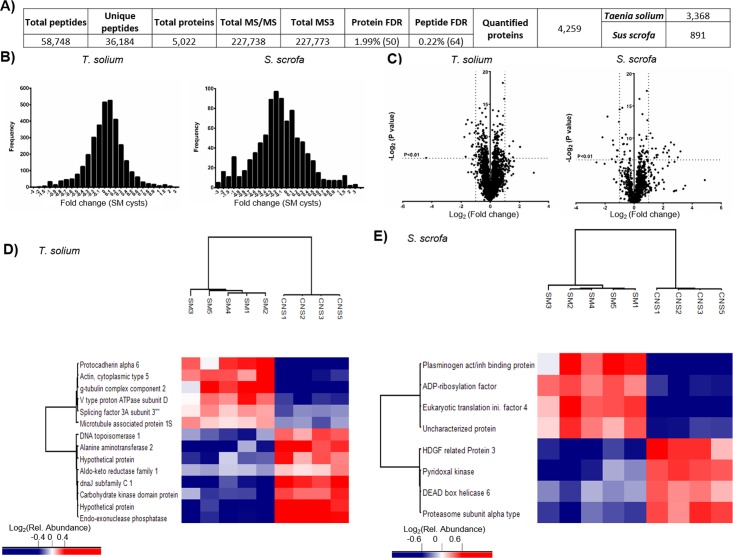
Proteomic analysis of Taenia solium cysts.A) Table summarizing peptide and protein quantification from the nine samples. Proteins were collapsed to a final protein-level FDR < 2%. B) Fold change distributions of proteins of skeletal muscle (SM) cysts. C) Volcano plots showing P-value and the Log2 (fold change CNS cysts/SM cysts) of proteins of SM and CNS cysts. D) Heat map showing the signature for T. solium proteins of SM and CNS cysts. E) Heat map showing the signature for the host (Sus scrofa) proteins quantified in protein extracts of SM and CNS cysts.